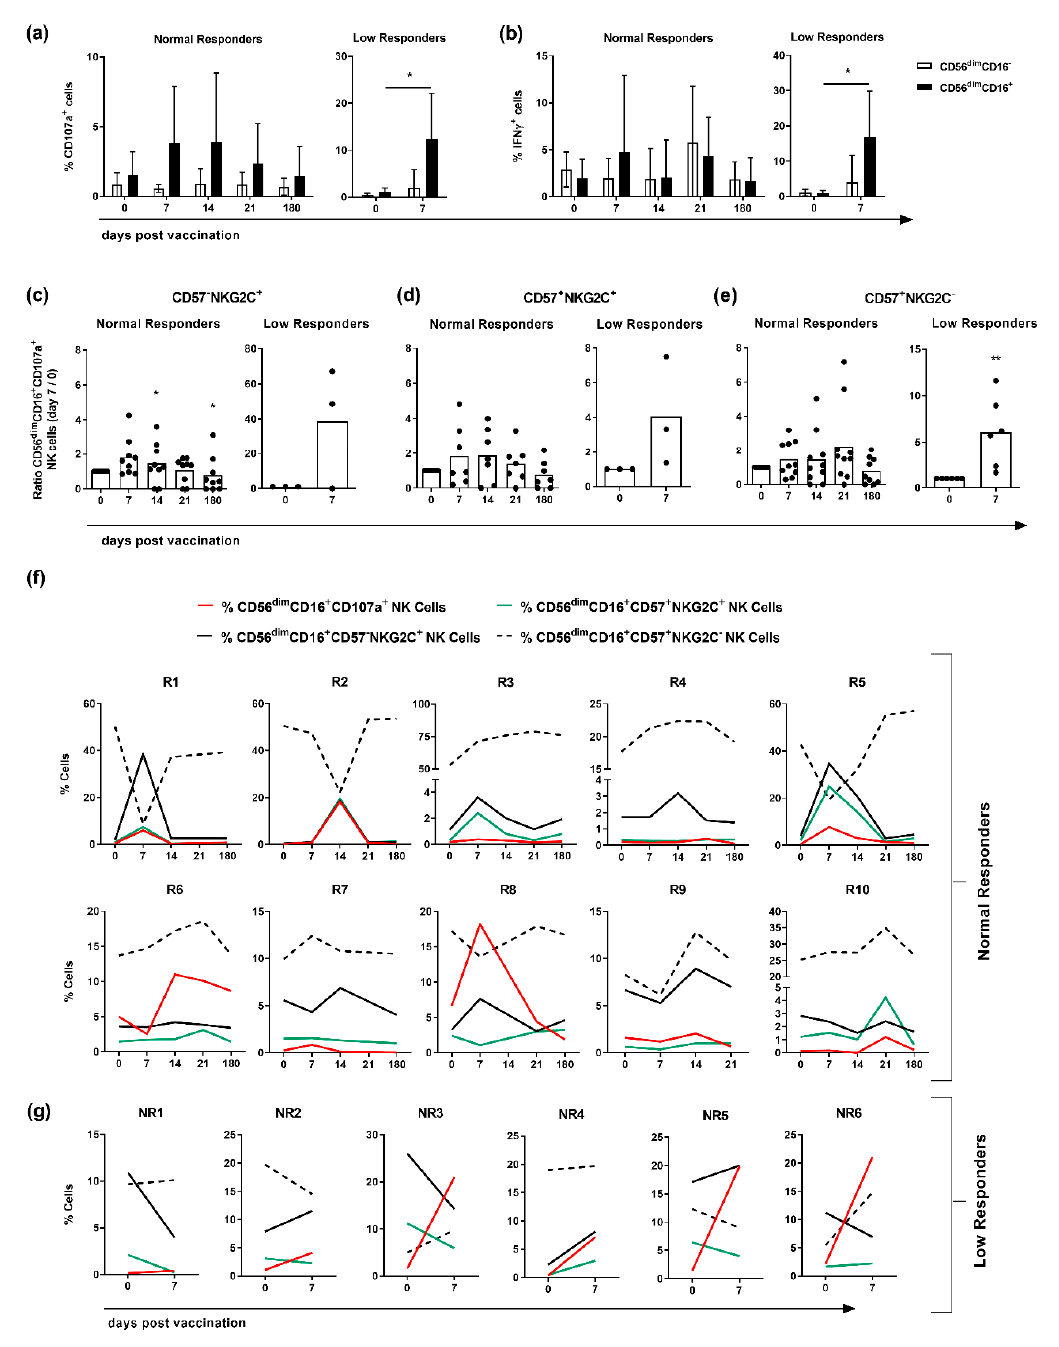
Figure 3. Functional differences characterize NK cells isolated from normal and low responders. Functional flow cytometric analysis of frozen PBMCs isolated from vaccinated individuals classified into normal and low responders. Frequencies of ( a ) CD107a + CD56 dim and ( b ) IFN γ + CD56 dim NK cells with regard to CD16 expression (CD16 − white/CD16 + black). Ratio of CD107a-expressing ( c ) CD57 − NKG2C + , ( d ) CD57 + NKG2C + and ( e ) CD57 + NKG2C − CD56 dim CD16 + NK cells isolated from responders and non-responders on the indicated days post- and pre-vaccination (day 0) depicted as scatter plots with bars indicating the mean with 95% confidence interval. ( f ) Frequency of CD56 dim CD16 + NK cells expressing CD107a (red solid), NKG2C + CD57 − (black solid), NKG2C + CD57 + (green), NKG2C − CD57 + (black dashed) shown for individual responders and ( g ) non-responders. Asterisks denote significant values as calculated by unpaired and non-parametric Mann–Whitney test. * p ≤ 0.05, ** p ≤ 0.01.